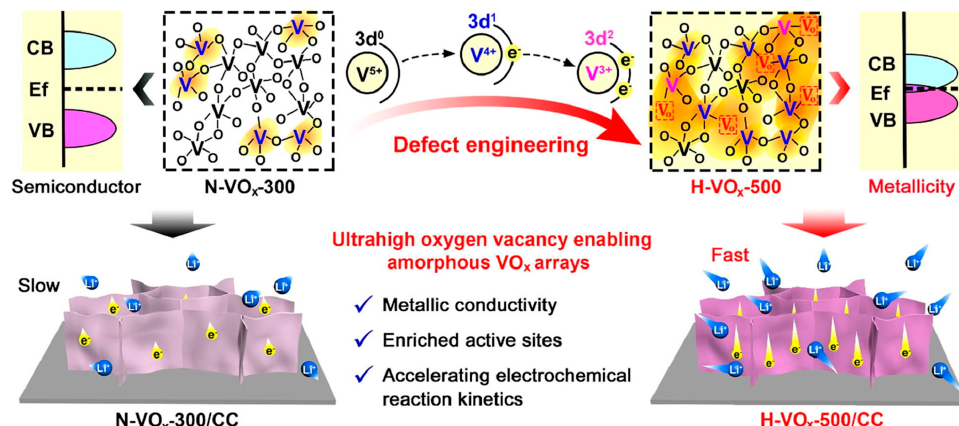
Figure 7. Schematic of the regulation of the V 3d band edge with high electrical conductivity by defect engineering and electrochemical advantages of the as-formed metallic amorphous VO x nanosheet arrays. Reprinted with permission from Ref. [116]. Copyright 2021